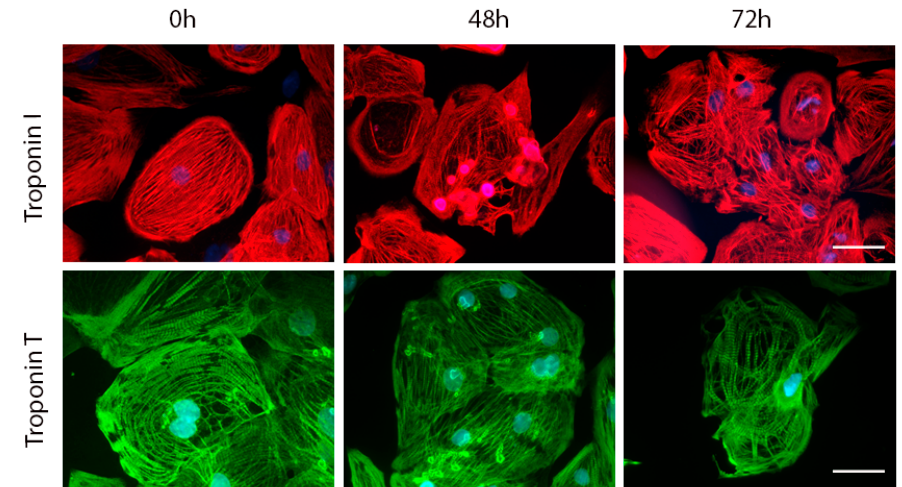
Figure 5. Effects of 1 µM DOX on the localization and arrangement of troponin T and troponin I in